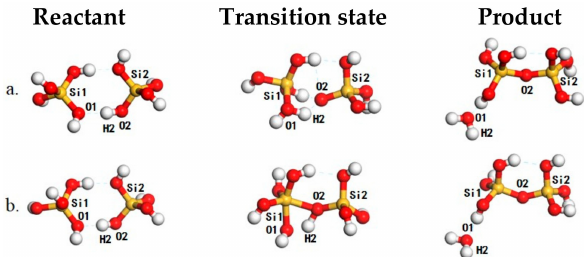
Figure 1. The structures of reaction species for the dimerization of ortho-silicic acid, including reactant ( left panel ), transition state ( middle panel ) and product ( right panel ) for the anionic-attack mechanism (AAM) ( a ) and the “molecular attack” mechanism (MAM) ( b ) mechanisms. The Si, O and H atoms are in yellow, red, and white,